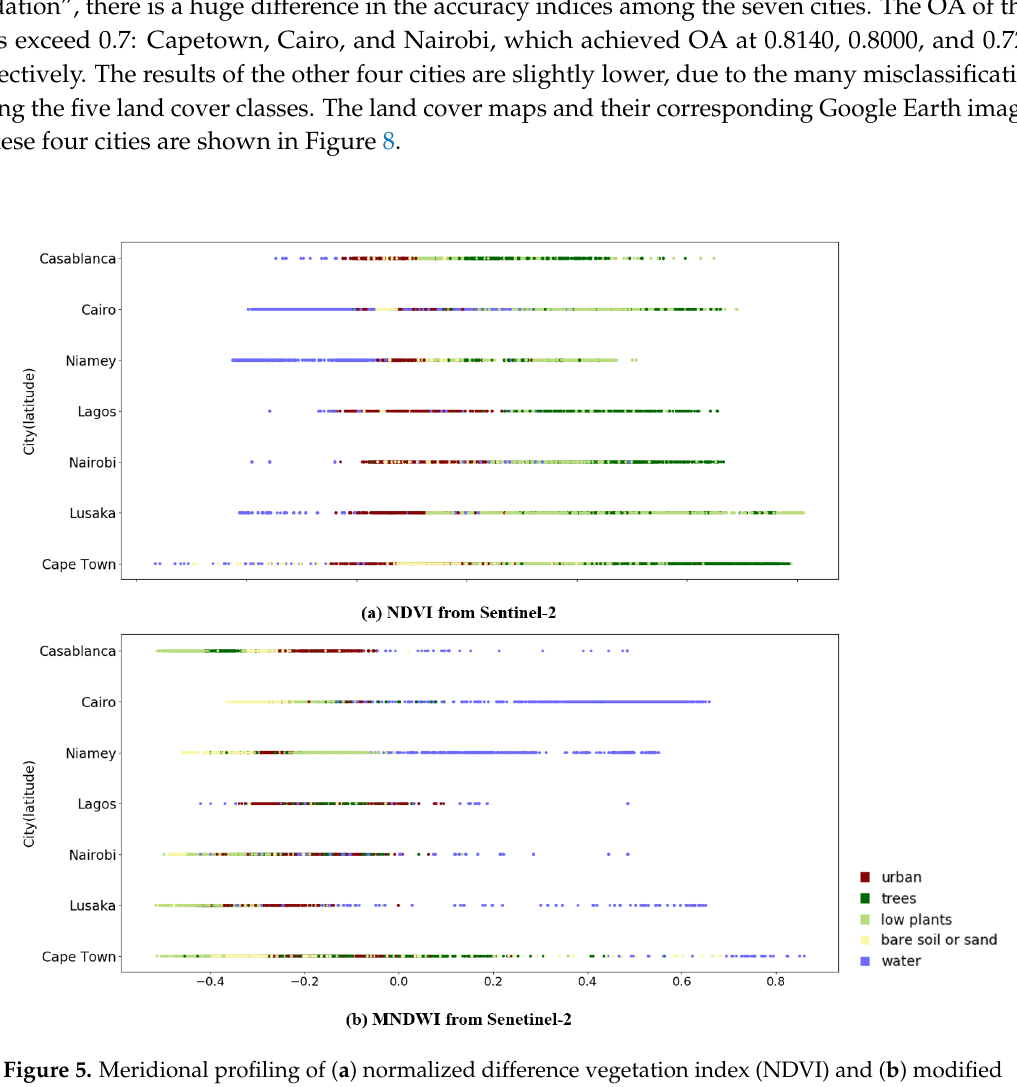
Figure 5. Meridional profiling of ( a ) normalized difference vegetation index (NDVI) and ( b ) modified normalized difference water index (MNDWI) from Sentinel-2 across all training cities, sorted from south (bottom) to north (top). Each pixel is depicted by its input feature value and land cover